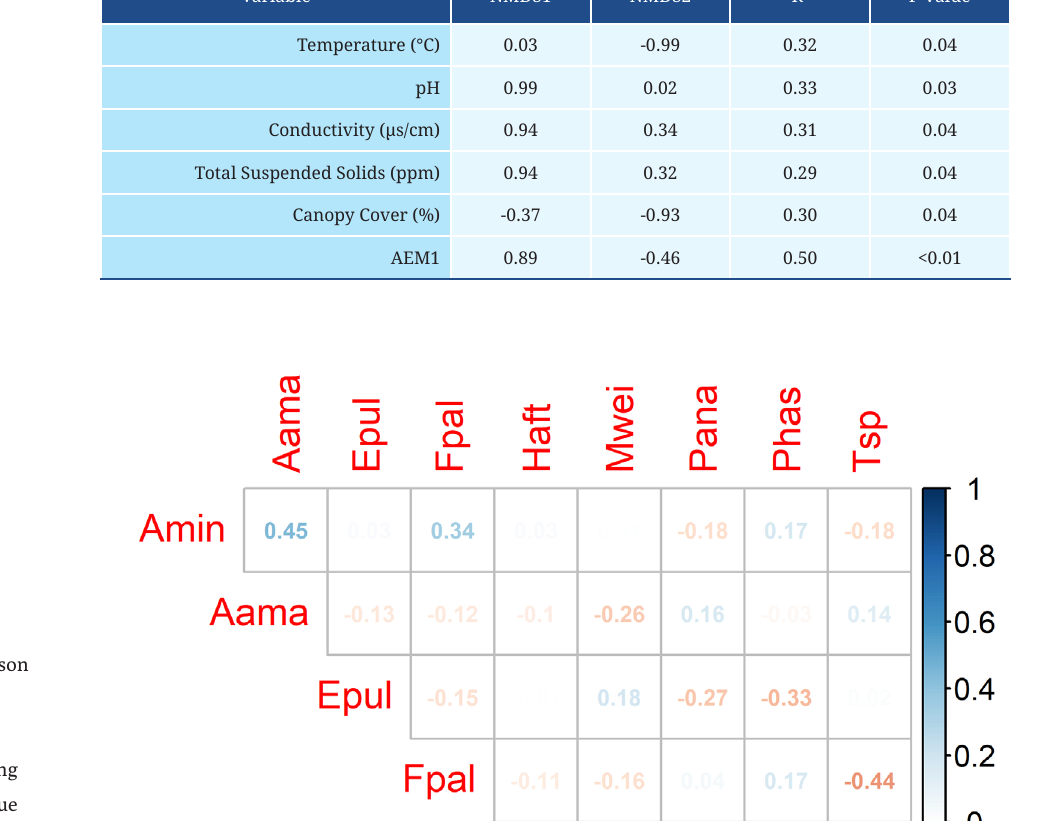
FIGURE 4 | Pairwise Pearson correlations in species abundance across the 20 sampling locations showing positive correlations in blue and negative correlations in red. Species codes are